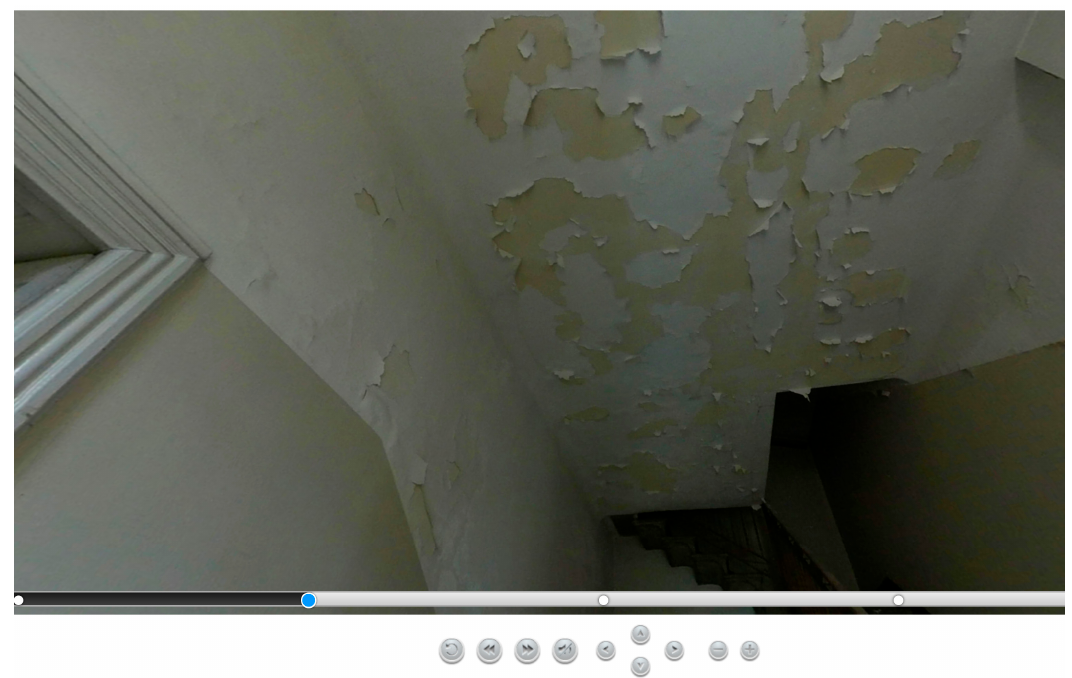
Figure 16. The virtual environment where multiple projections can be inspected.